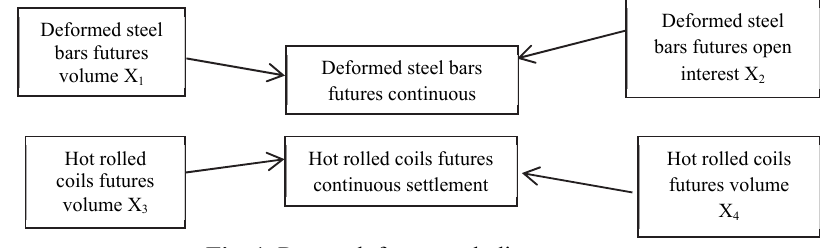
Fig. 1. Research framework